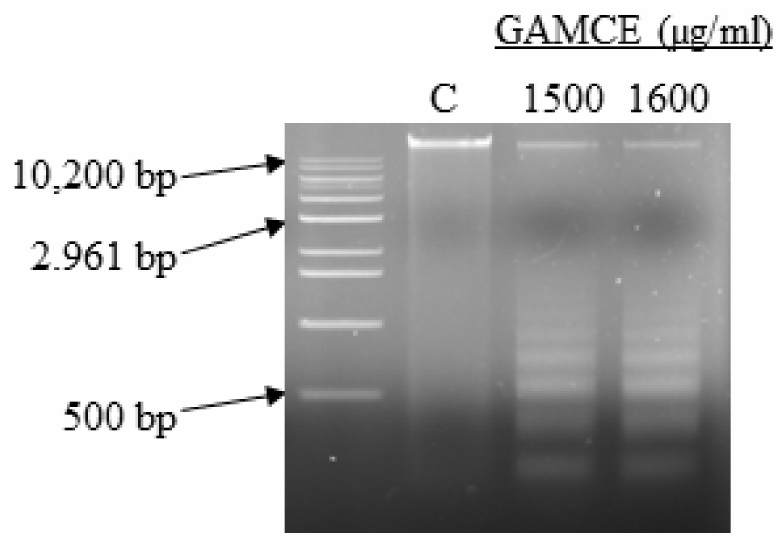
Figure 6. DNA fragmentation of GAMCE (1500 and 1600 µ g/mL) treated HeLa cells for 24 h as compared to the control, HeLa genomic DNA was extracted and separated by 1.5% agarose gel electrophoresis with 100 V run for 30 min.